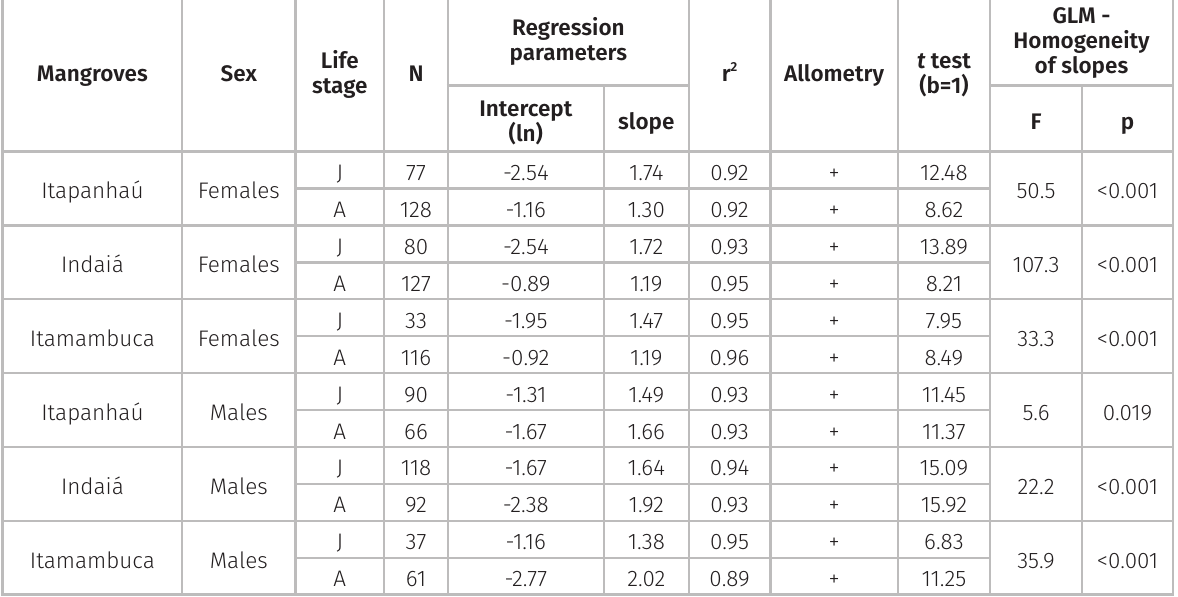
Table III. Morphometric analysis for each sex and life stage (J, juvenile and A, adult) of Minuca vocator of the populations from Itapanhaú, Indaiá, and Itamambuca mangroves. N, number of fiddler crabs. Regression parameters and coefficient of determination of transformed data (ln) using the carapace width as independent variable, and the abdomen width and the length of the propodus of the major cheliped as dependent variables to females and males, respectively. t test values that confirm the allometry of each growth phase, and results of the GLM - Homogeneity of slopes, comparing the regression coefficient (slope = b) between juvenile and adult M. vocator within each sex and